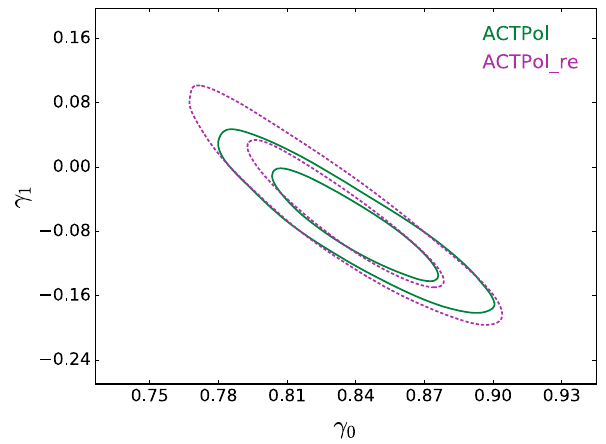
Fig. 4 Confidence contours for the γ( z ) parameters in γ( z ) = γ 0 ( 1 + γ ) . Green solid lines and magenta dashed lines correspond to the fits 1 z obtained on the the full and reduced ACTPol cluster sample